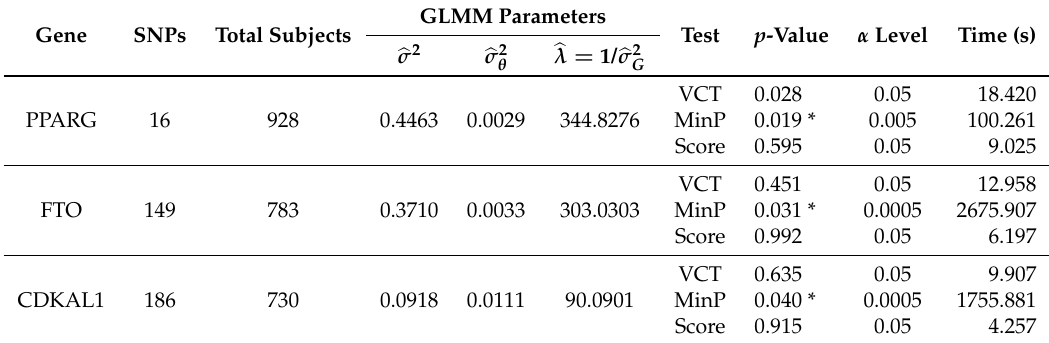
Table 3. Sample size, GLMM parameters, p -values and execution times for the analysis of the Baependi